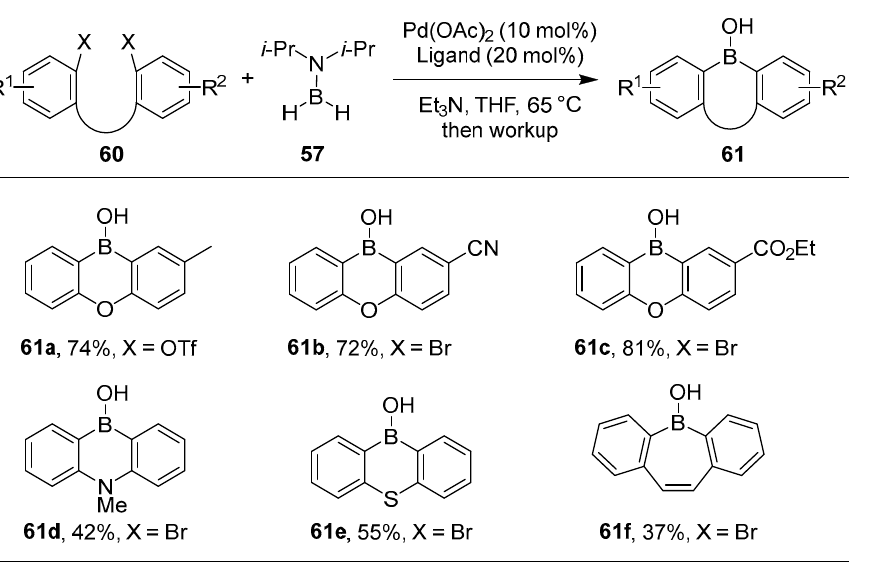
Scheme 19. Synthesis of cyclic borinic acids catalyzed by palladium with DIPOB 57 .